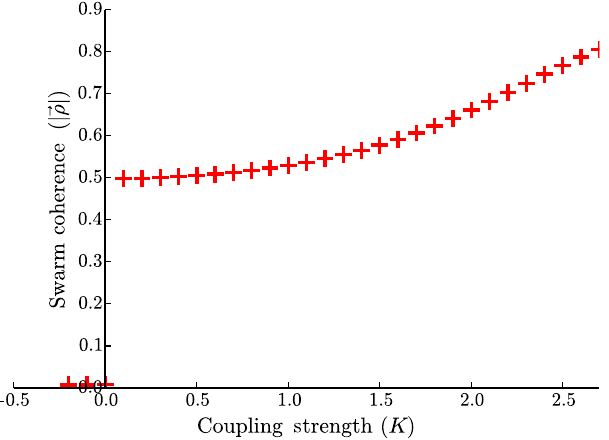
FIG. 9. Phase transition for interacting three-dimensional extended-body agents described by Eqs. (56) – (58). The dynamics of individual agents in this system have been constructed to satisfy constraints imposed by extended-body dynamics, and are not equivalent to the dynamics of the generalized Kuramoto model described in Sec. III. Despite this, we continue to observe a discontinuous jump in the asymptotic steady-state value of j ρ j as K is increased through